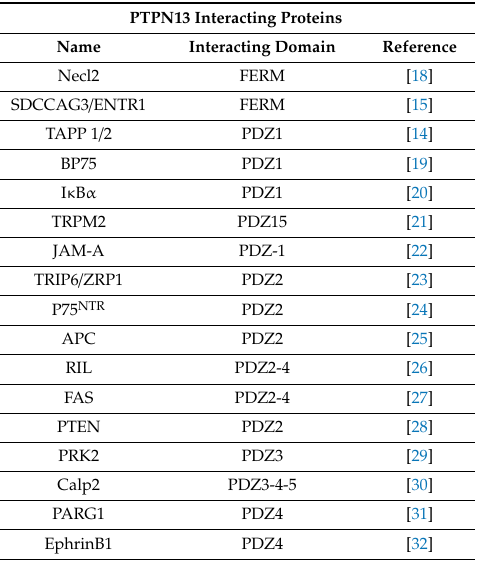
Figure 1. PTPN13 structure, interactions, and substrates. Interactors or substrates in green were involved in PTPN13 tumor suppressor role. Interactors or substrates in red were involved in PTPN13 pro-tumoral role. KIND domain: kinase non-catalytic C-lobe domain (unknow function), FERM: 4.1 / Ezrin / radixin / moesin domain (protein / protein and protein / plasma membrane interaction), PDZ domains: PSD95 / Dlg1 / Zo-1 domain (protein / protein interaction domain), Calp2: Calpain-2, β -cat: β -catenin. Table 1. PTPN13 interacting